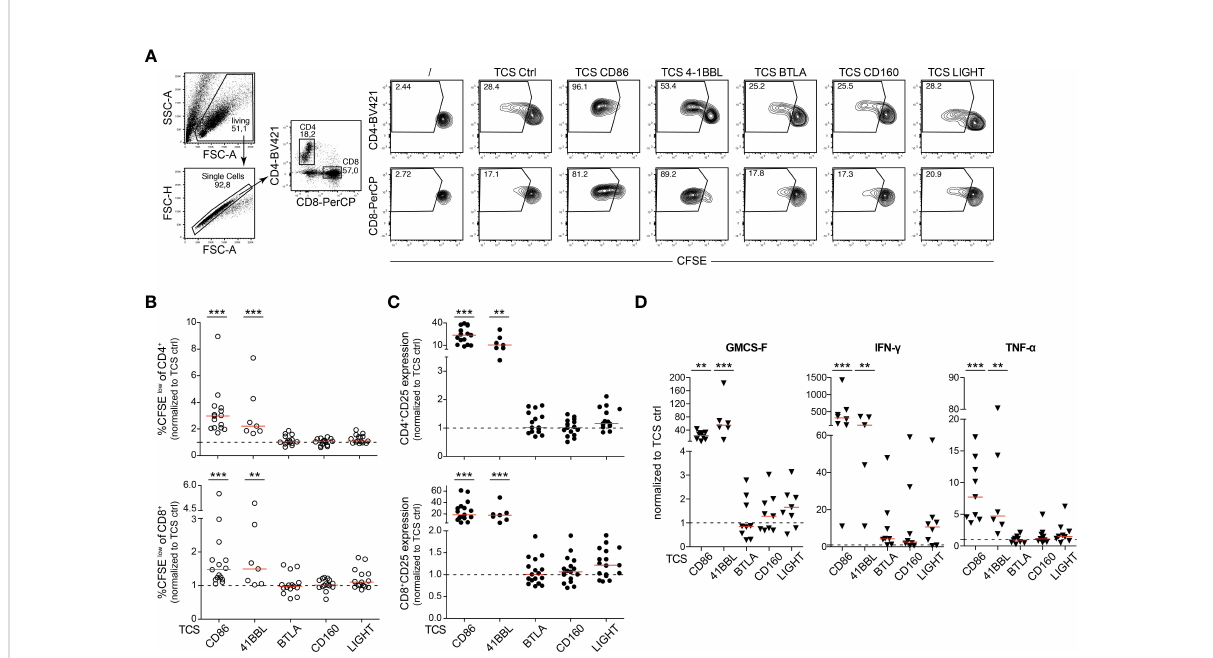
FIGURE 6 HVEM engagement in primary human T cells. (A) Representative contour plots of CFSE-labelled PBMCs stimulated with TCS ctrl, TCS CD86, TCS 4-1BBL, TCS BTLA, TCS HVEM, TCS CD160 and TCS LIGHT for 5 days. Percentages of proliferated (CFSE low ) of CD4 + and CD8 + T cells is shown. (B, C) CFSE-labelled PBMCs from healthy donors were stimulated for 5 days with the indicated TCS. Proliferation (CFSE low ) and CD25 upregulation of CD4 + and CD8 + T cells was measured at day 5. Data is normalized for each donor to stimulation with TCS ctrl. Each data point represents the mean of triplicate measurement of one donor (n = 15; TCS 4-1BBL n = 7). (D) Cell culture supernatants of PBMCs stimulated with TCS cells were harvested at day 5 and cytokine expression pro fi le (IFN- g , GM-CSF and TNF- a ) was measured via Luminex multiplex cytokine analysis. Each data point represents the mean of triplicate measurement of one donor (IFN- g : n = 8, TCS 4-1BBL n = 5; GM-CSF and TNF- a : n = 9, TCS 4-1BBL n = 6). (B-D) For statistical evaluation, a one-way ANOVA with Dunn ’ s multiple-comparisons test was performed (***p ≤ 0.001; **p ≤ 0.01). Median is shown (red line). Dotted line depicts control